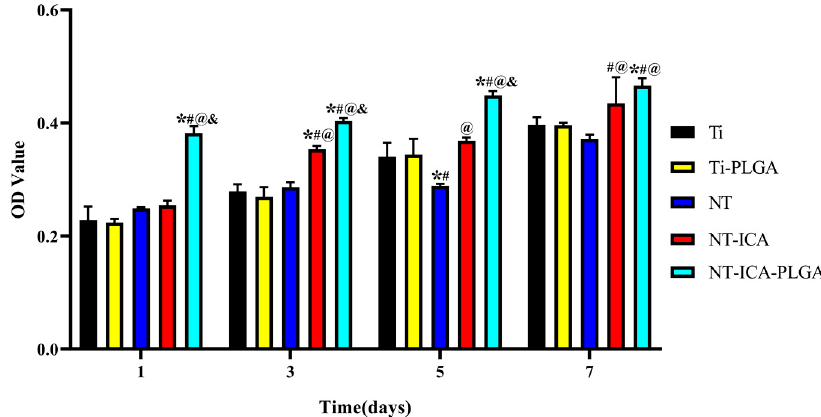
Figure 7. CCK-8 assay results of MC3T3-E1 cells on different surfaces after 1, 3, 5, and 7 days. * indicate statistical significance compared to Ti, # indicate statistical significance compared to Ti-PLGA, @ indicate statistical significance compared to NT and & indicate statistical significance compared to NT-ICA group ( p < 0.05). The values were calculated as mean ± standard deviation, n = 3. The experiments were repeated three times.